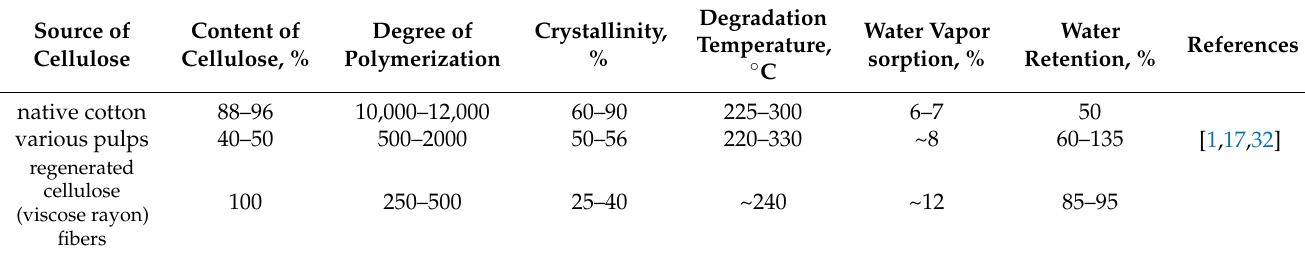
Table 1. Important physico-chemical properties of cellulose depending on the source.